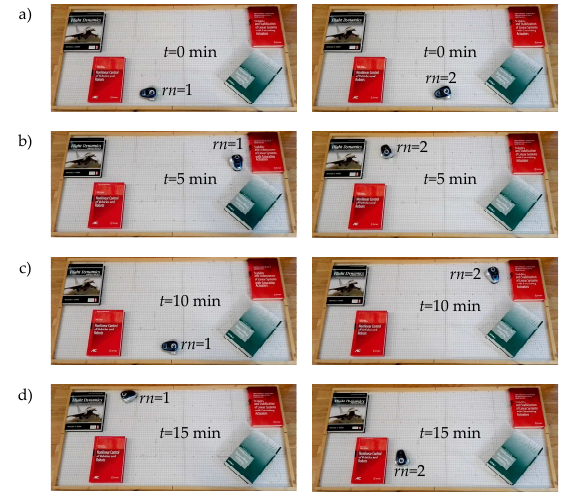
Figure 13. Snapshots of experiment 2. Positions of the robots at: ( a ) t = 0 min; ( b ) t = 5 min; ( c ) t = 10 min; and ( d ) t = 15